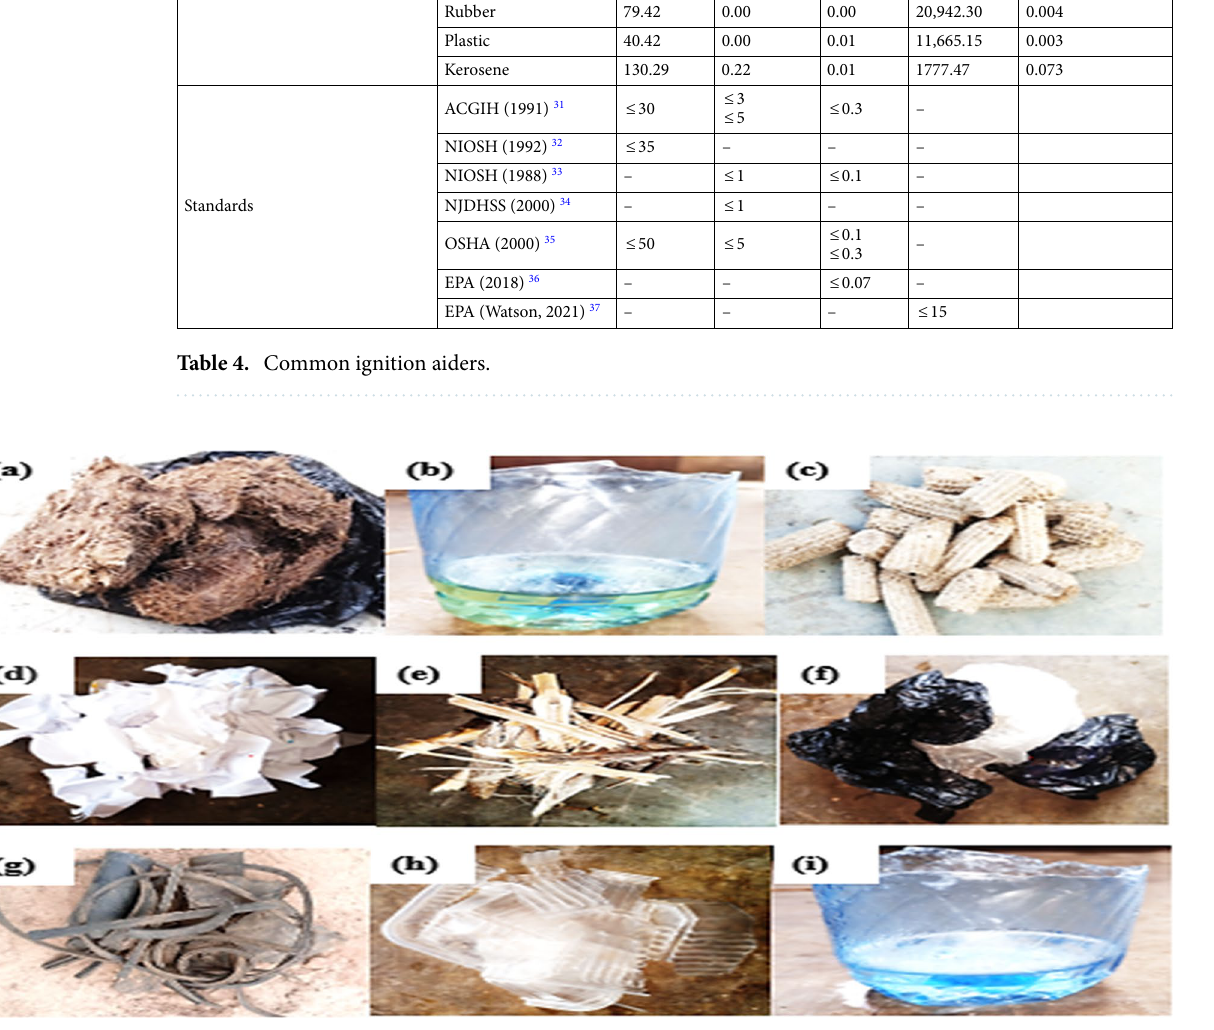
Figure 3. Ignition aiders ( a) Oguso, ( b) petrol, ( c) maize cob, ( d) paper (printed-on type), ( e) wood, ( f) nylon, ( g) rubber, ( h) plastic, ( i) kerosene ( source: present study,